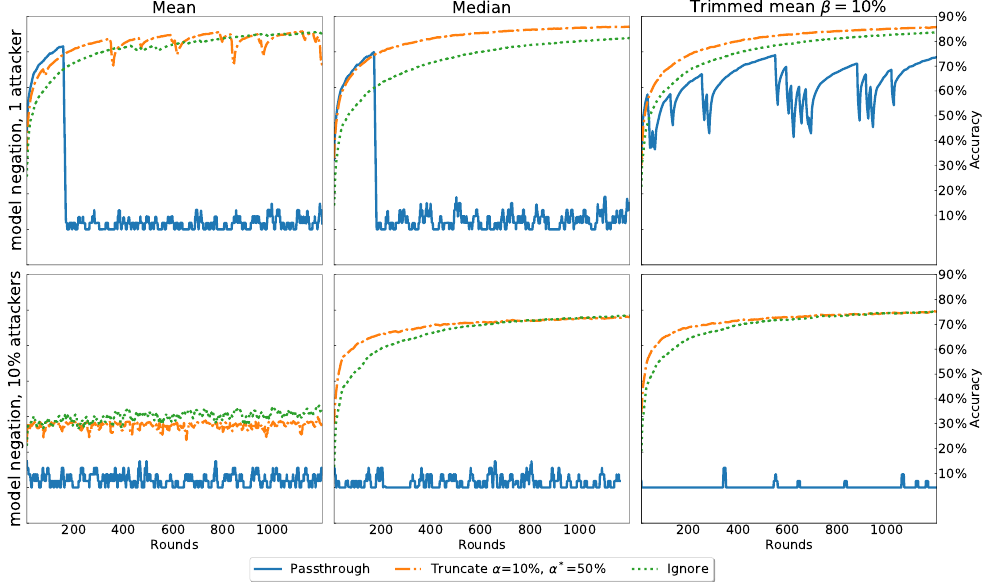
Figure 3. Accuracy by round without any attackers for the Shakespeare experiments. Curves correspond to preprocessing procedures, and columns correspond to different aggregation methods.